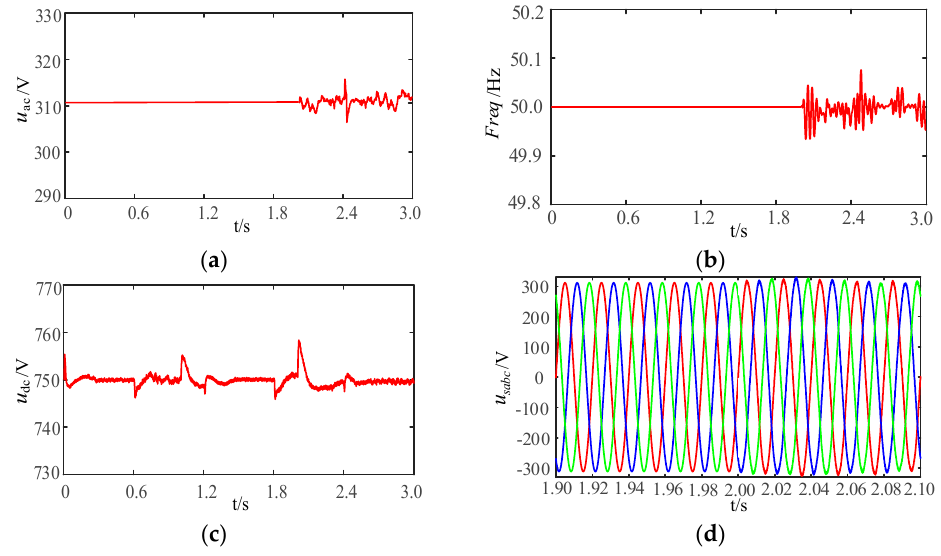
Figure 11. Parameter characteristics of energy router in case 1: ( a ) AC bus phase voltage amplitude; ( b ) AC bus frequency; ( c ) DC bus voltage; ( d ) Three-phase voltage waveforms of AC bus around the moment of mode switching.